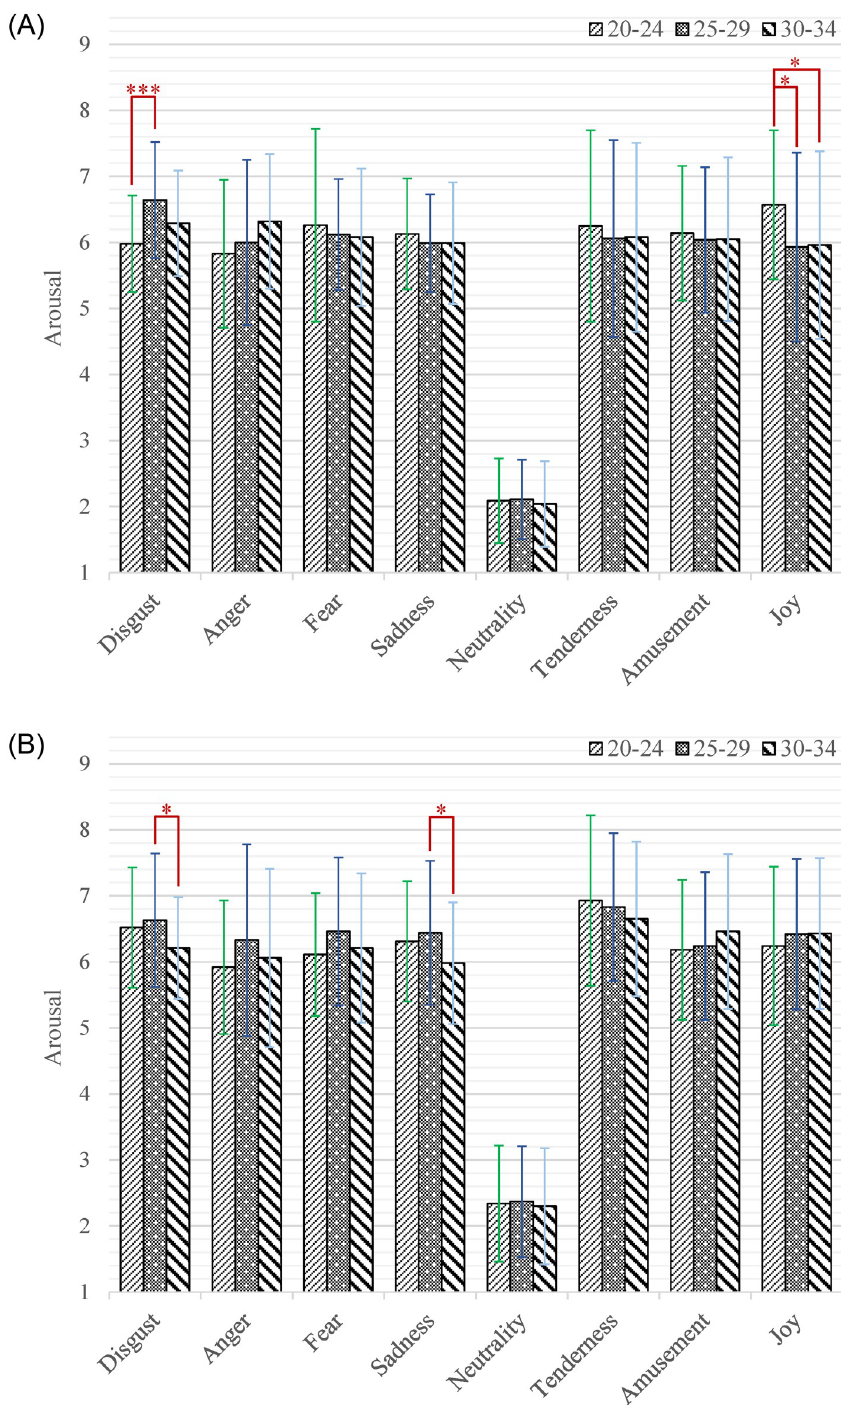
Fig 7. The arousal scores of each category of emotion-inducing short videos among participants with different ages. A: Male. B: Female. Statistical significance: * p < 0.05, ** p < 0.01, *** p < 0.001. Unless marked with the asterisk, no significant differences between these groups were